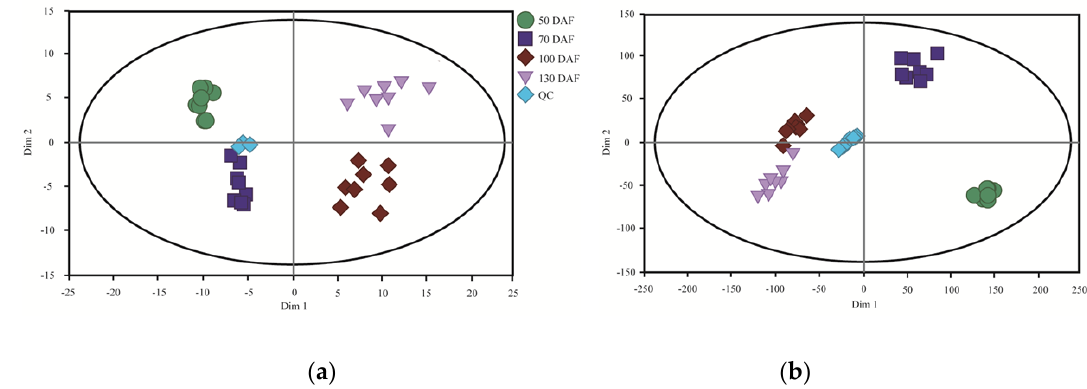
Figure 1. Quality control of samples from biological material. ( a ) Principal component analysis (PCA) of gas chromatography-mass spectrometry (GC-MS) analysis. ( b ) PCA of liquid chromatography-mass spectrometry (LC-MS) analysis.